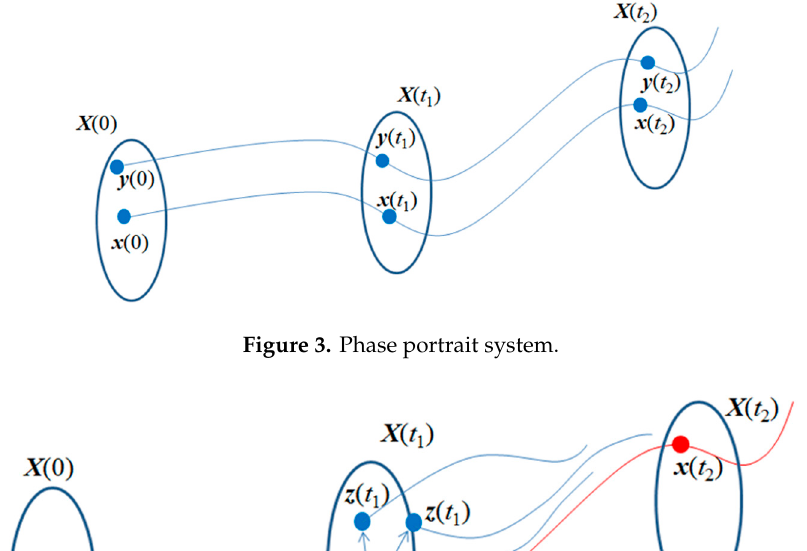
Figure 4. System deflection.